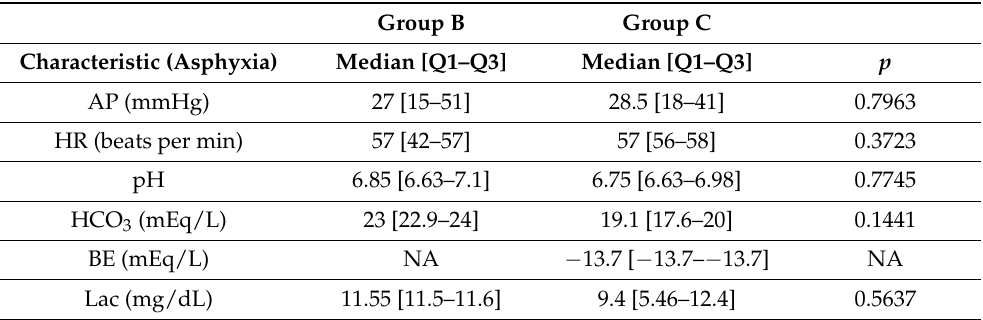
Table 3. Animal characteristics at asphyxia. NA: not applicable. Venous and arterial blood samples and hemodynamic parameters. AP = Arterial Pressure, HR = Heart Rate, pH = potential of hydrogen, HCO 3 = Bicarbonate, BE = Base Excess, Lac = Lactate. Group B